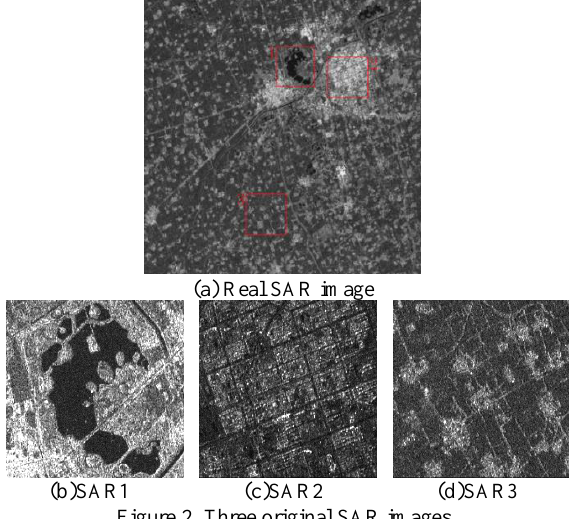
Figure 2. Three original SAR